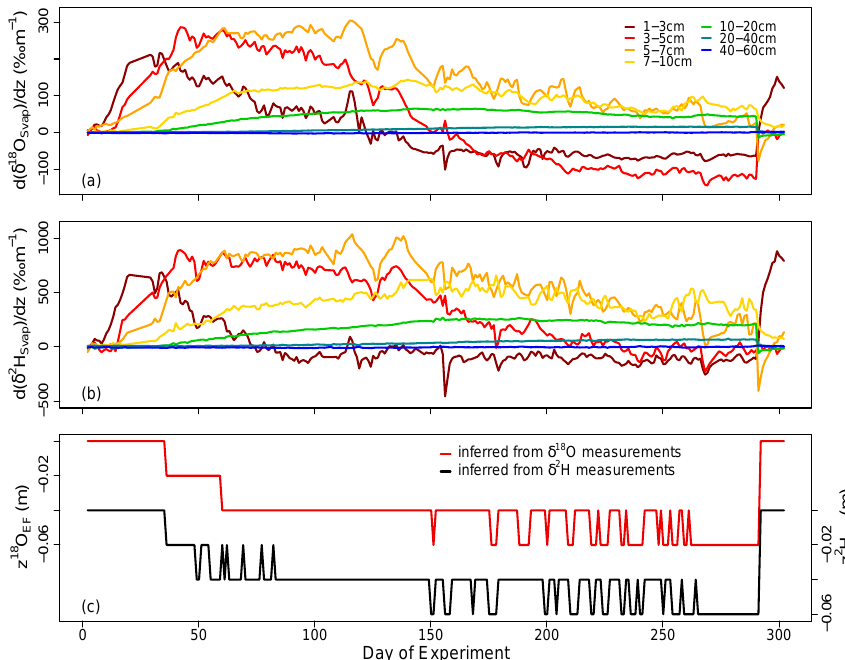
Figure 8. (a) and (b) 1 H 18 O and 1 H 2 H 16 O composition gradients calculated between consecutive observation points in the soil. (c) Evolution 2 of the evaporation front depths z 18 O EF [m] (red solid line) and z 2 H EF [m] (black solid line) inferred from the 1 H 18 composition